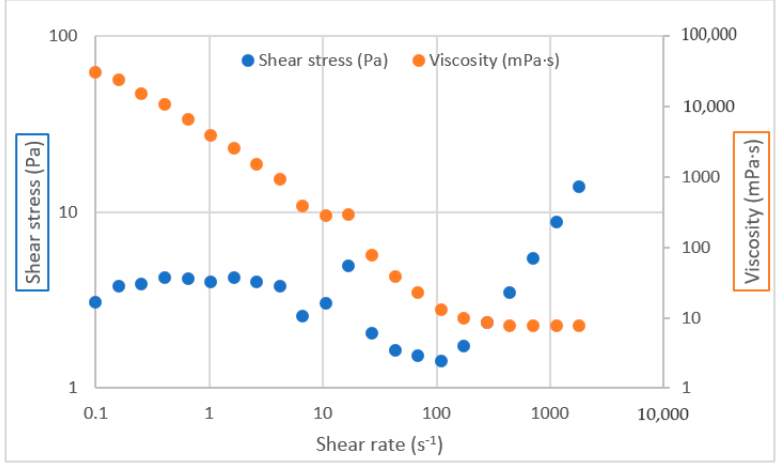
Figure 7. Rheological properties of the 20%—PVP 40-50 G/sterile water sample.